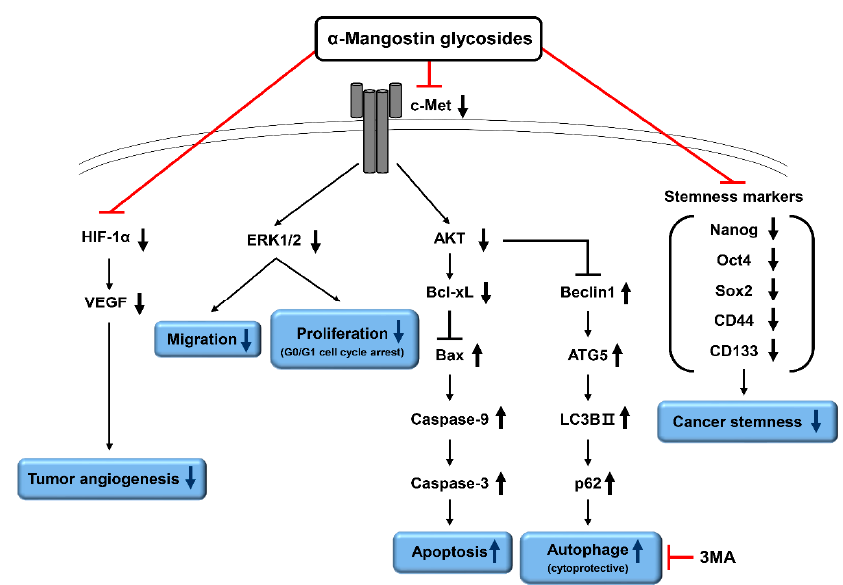
Figure 11. Proposed molecular mechanisms of anticancer action of α -mangostin glycosides in HCC cells. The α -mangostin glycosides, Man-3DG and Man-6DG, may exhibit potent anticancer and antiangiogenic activities against HCC cells by downregulating c-Met, HIF-1 α , and cancer stemness regulators. In addition, the combination with autophagy inhibitor can be a promising strategy for improving the anticancer effects of α -mangostin glycosides against HCC.